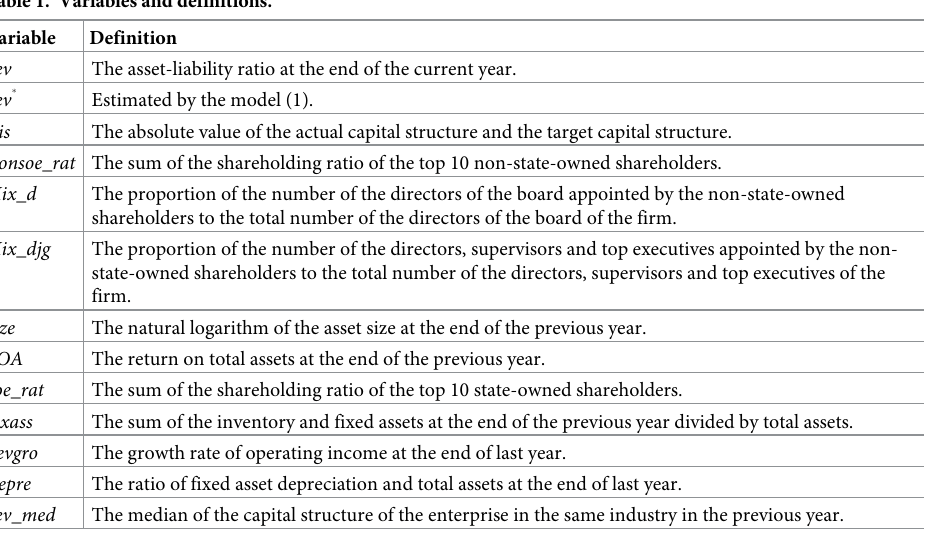
Table 1. Variables and definitions.